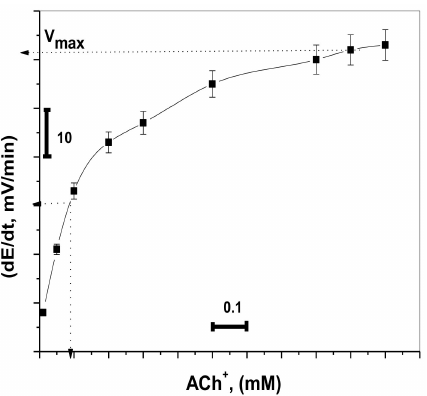
Figure 6. Initial reaction rates obtained by the proposed sensor fitted to the Michaelis–Menten equation (acetylcholinesterase (AchE) activity = 0.5 IU / L).